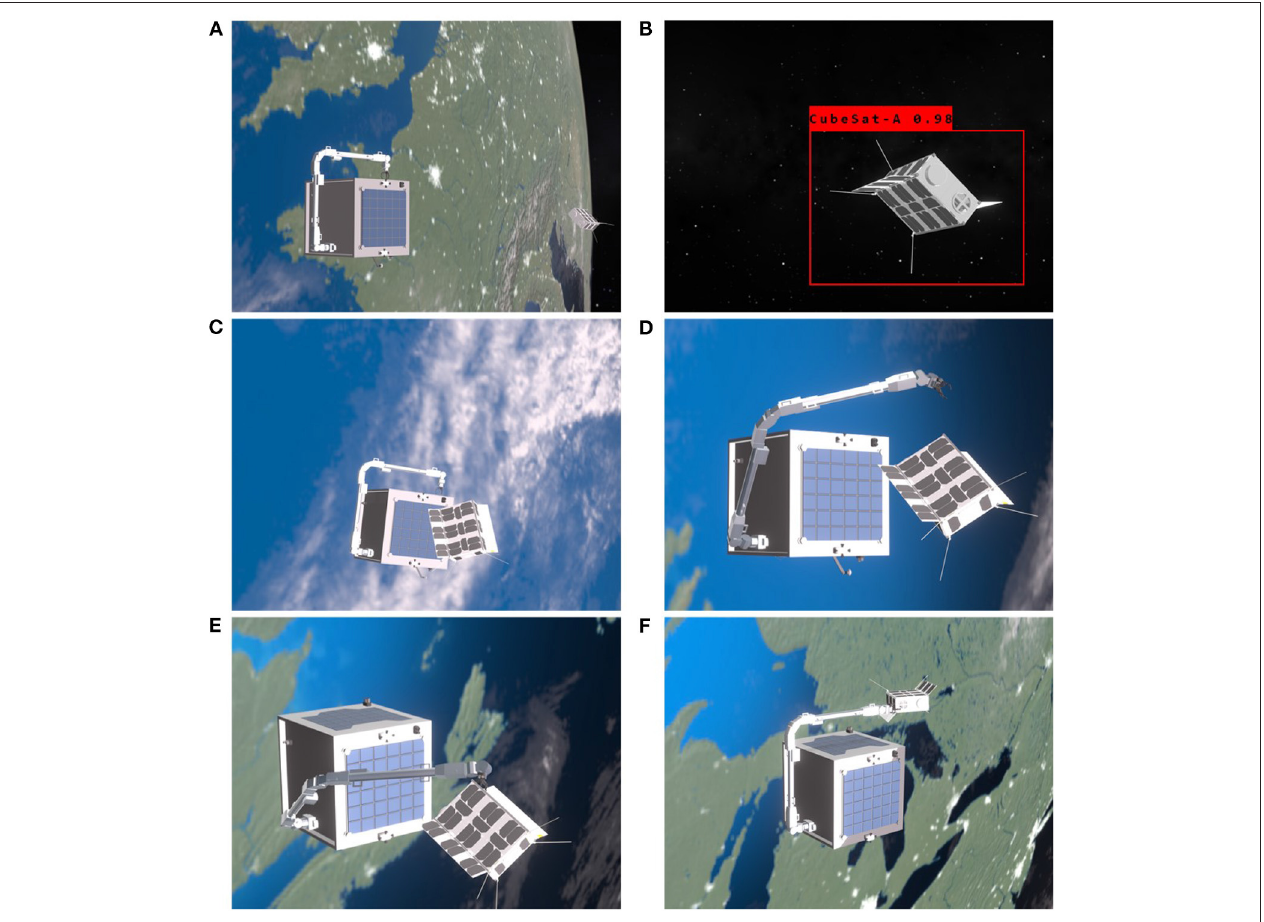
FIGURE 8 | The simulation of the intelligent orbital Guidance, Navigation, and Control (GNC) operations: (A) the starting position of the simulation, (B) target identification and continuously pose estimation of the target within the camera array range, (C) final approaching with adjusted orbital and attitude control to an idea manipulation-ready state, (D) initiate the planned optimized trajectory to dock the end-effector to the pre-grasping point, (E) the end-effector arrives the dedicated located and executing grasping and rigidization, (F) plan and move the target CubeSat to for servicing. The animation is rendered in real-time in the Eevee engine with the actual relative position of the service spacecraft and the target, robotic arm trajectory points with kinematics, and time-synchronized camera readings in the render